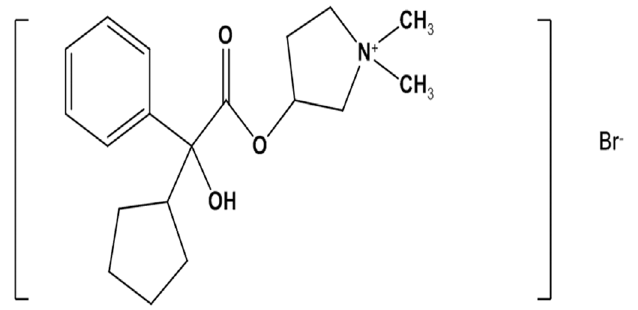
FIGURE 1 - Chemical structure of